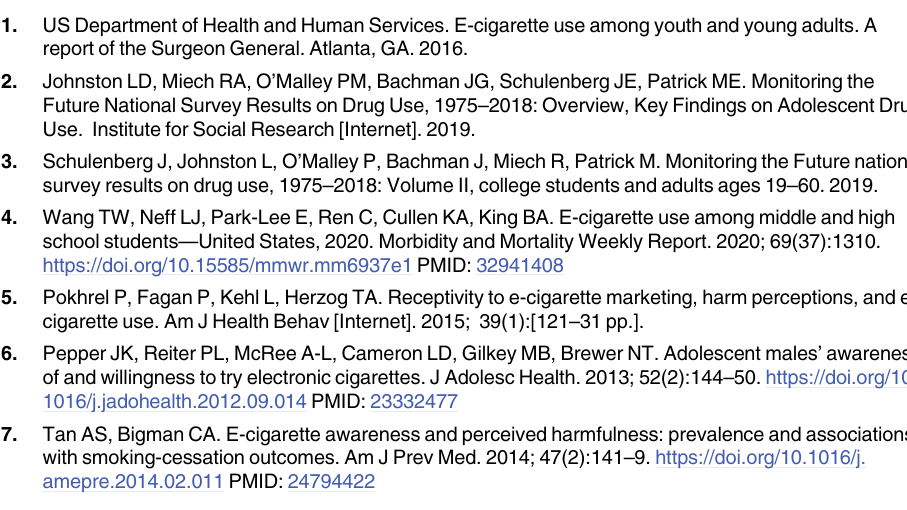
S1 Table. List of keywords to retrieve e-cigarette TV advertising data from Kantar Media. S2 Table. Total quarterly e-cigarette TV advertising expenditure and quarterly e-cigarette TV ratings overall and by age groups, 2013 to